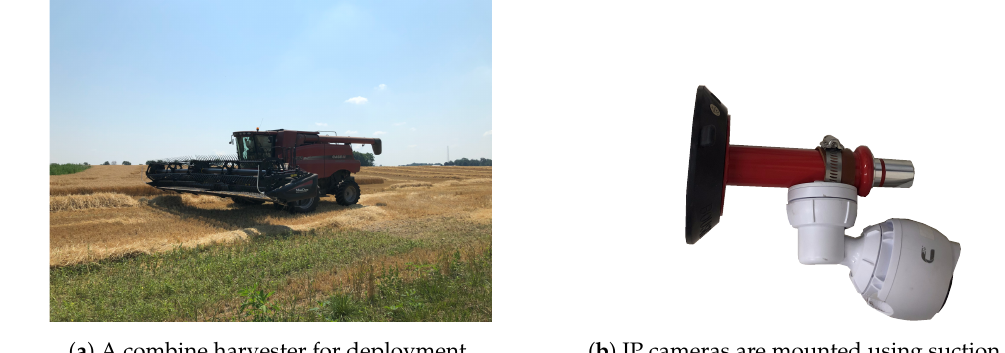
Figure 12. ISOBlue HD was deployed into a combine harvester for collecting a wheat harvest dataset. IP cameras were fastened onto heavy-duty suction cups for mounting on different surfaces.